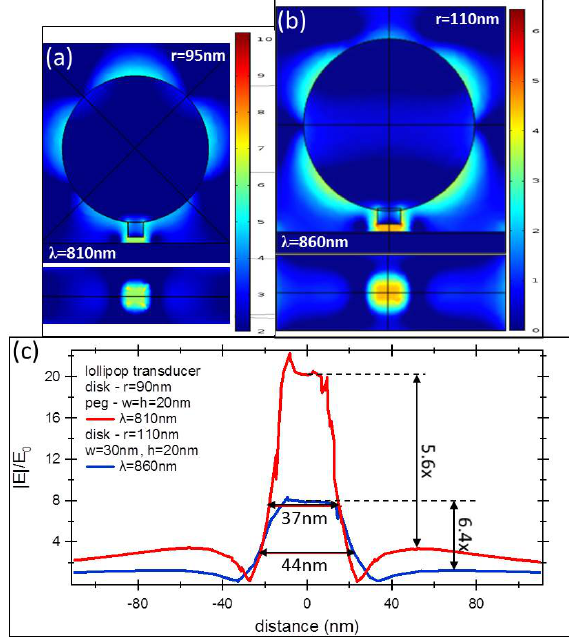
Figure 2: Lollipop transducer. (a), (b) Electric field profile (logarith- mic scale) of the lollipop transducer through a cross-section of the NFT (above) and at a distance of a 7 nm from the transducer (below) for (a) 90° and (b) 180° coupling angle between the MZI arms. (c) Electric field profile (distribution) along the width direction through the center of the lollipop transducer and at distance of a 7 nm from transducer normalized to E 0